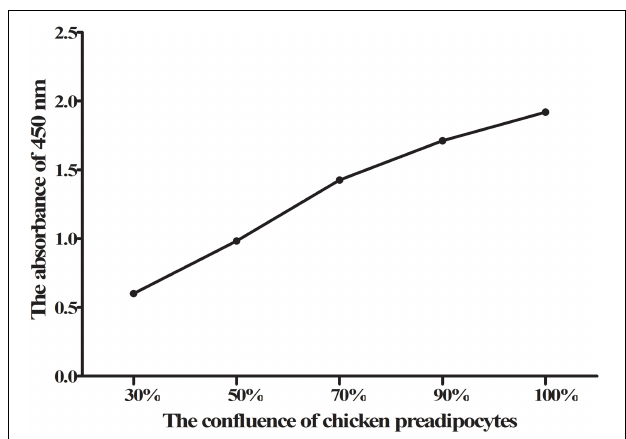
FIGURE 5 | CCK-8 results of chicken primary preadipocyte proliferation. The absorbance of 450 nm gradually increased with the confluence of chicken primary preadipocytes increased, which showed that the primary preadipocytes of chicken were in a normal proliferative